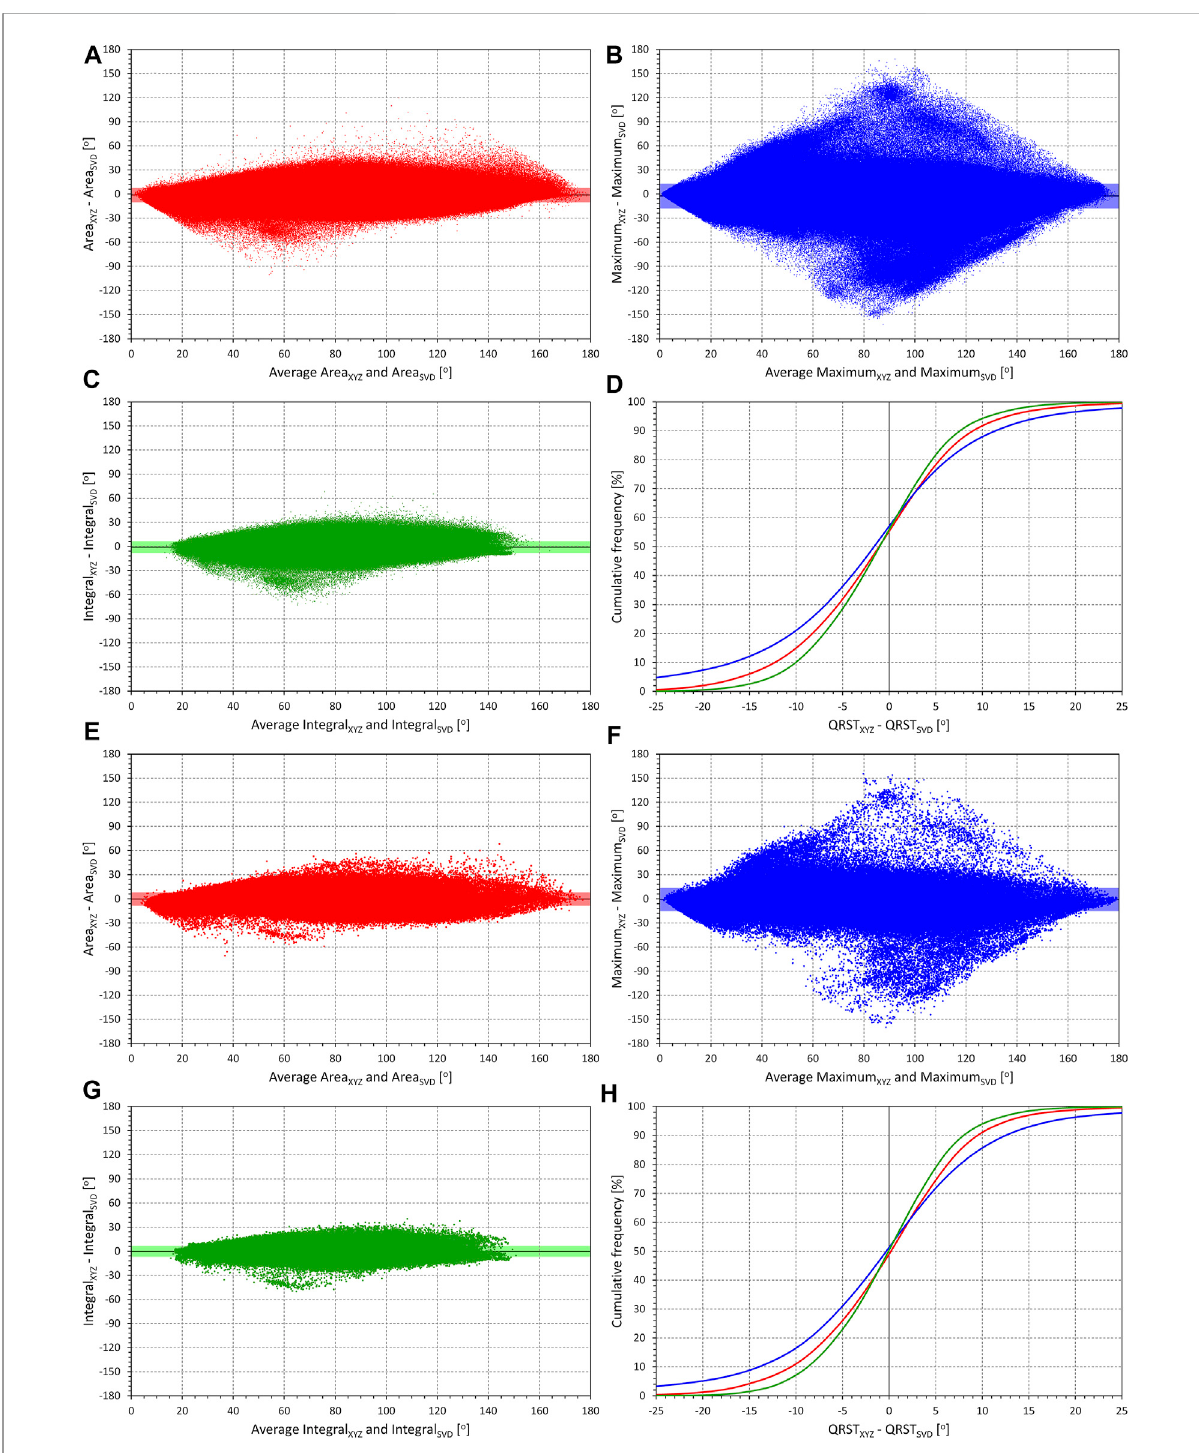
FIGURE 1 Comparison of QRS-T angle measurements in XYZ and SVD orthogonal projections. The matrix (XYZ) and the singular value decomposition (SVD)methodsareusedtoderiveorthogonalleads.Inindividualpanels,themeasurementsinallsubjectsarepooledandthedifferencebetweenXYZ and SVD angle expressions is plotted against their averaged value. The mean difference is shown by a bold horizontal line while the light-coloured band (along the horizontal axis) shows the spread of mean ± standard deviation. Panels (A) (comparisons of Area XYZ and Area SVD ), (B) (comparisonsof Maximum XYZ and Maximum SVD ), and (C) (comparisons ofIntegral XYZ and Integral SVD ) show data derived from individual beats. Panel (D) shows cumulative distributions of the Method XYZ -Method SVD values shown in panels (A) , (B) , and (C) (the colours of the graphs in this panel